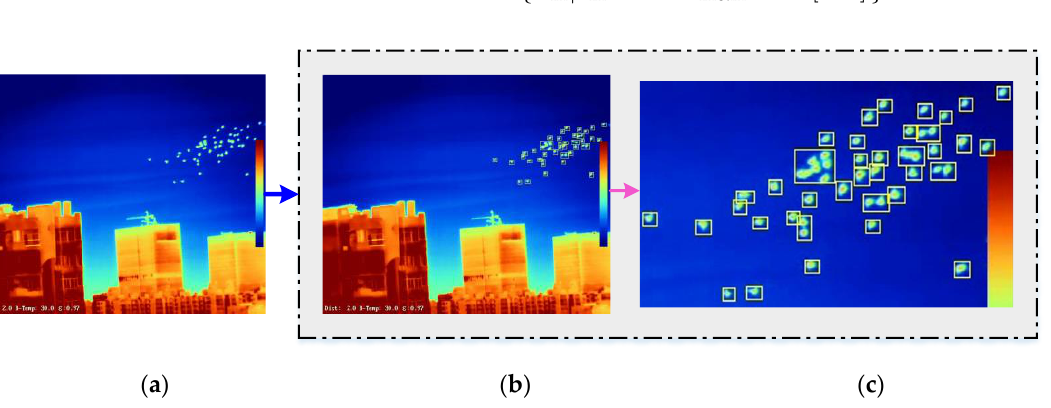
Figure 2. The original image and the target detection results, ( a ) original image; ( b ) target detection results of TVF algorithm; ( c ) enlarged target detection results of TVF algorithm.